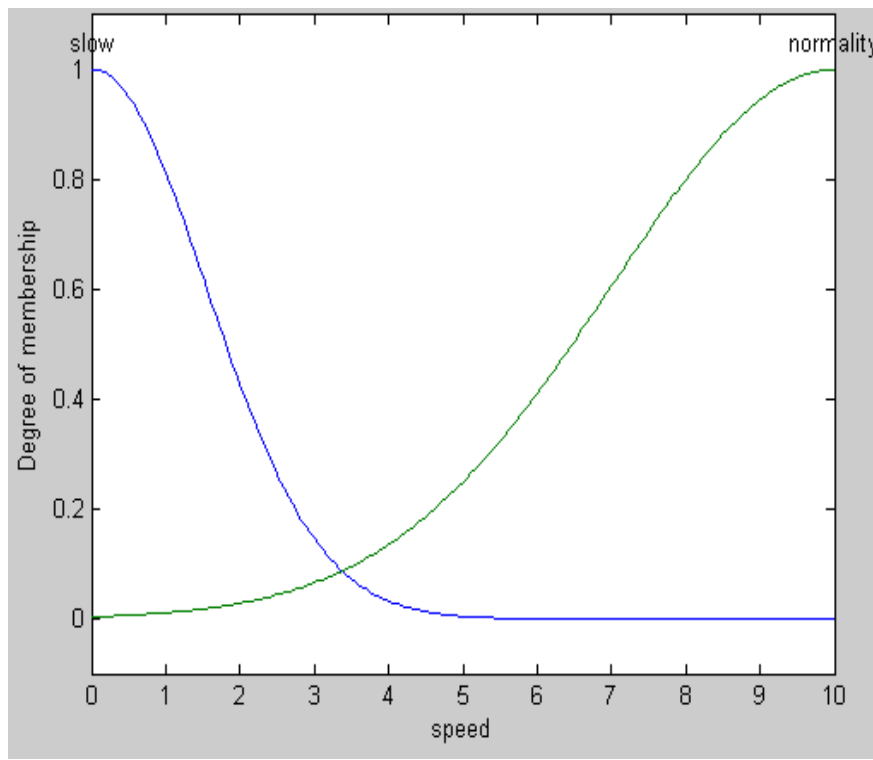
Figure 6. Driving speed according to the road condition.